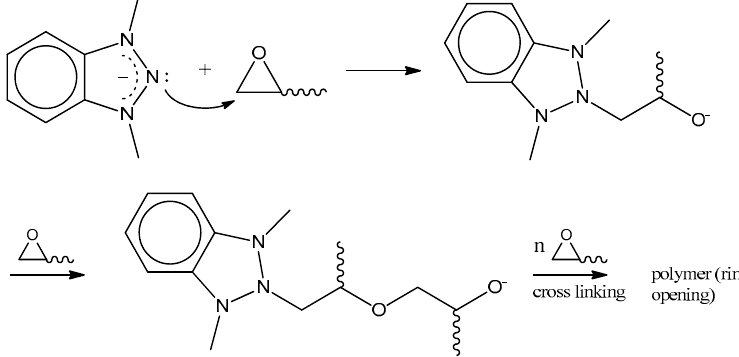
Figure 6. Curing of epoxy resins with BTAH.